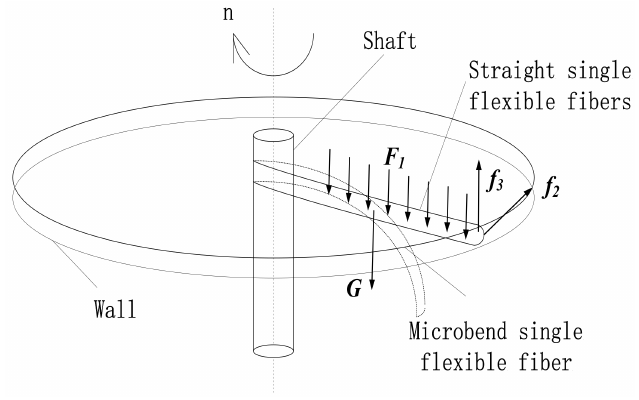
Figure 2. Single flexible helical blade axial force